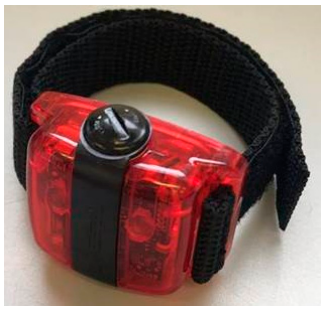
Figure 7. Actigraph wGT3X-BT. Figure 6. Actigraph